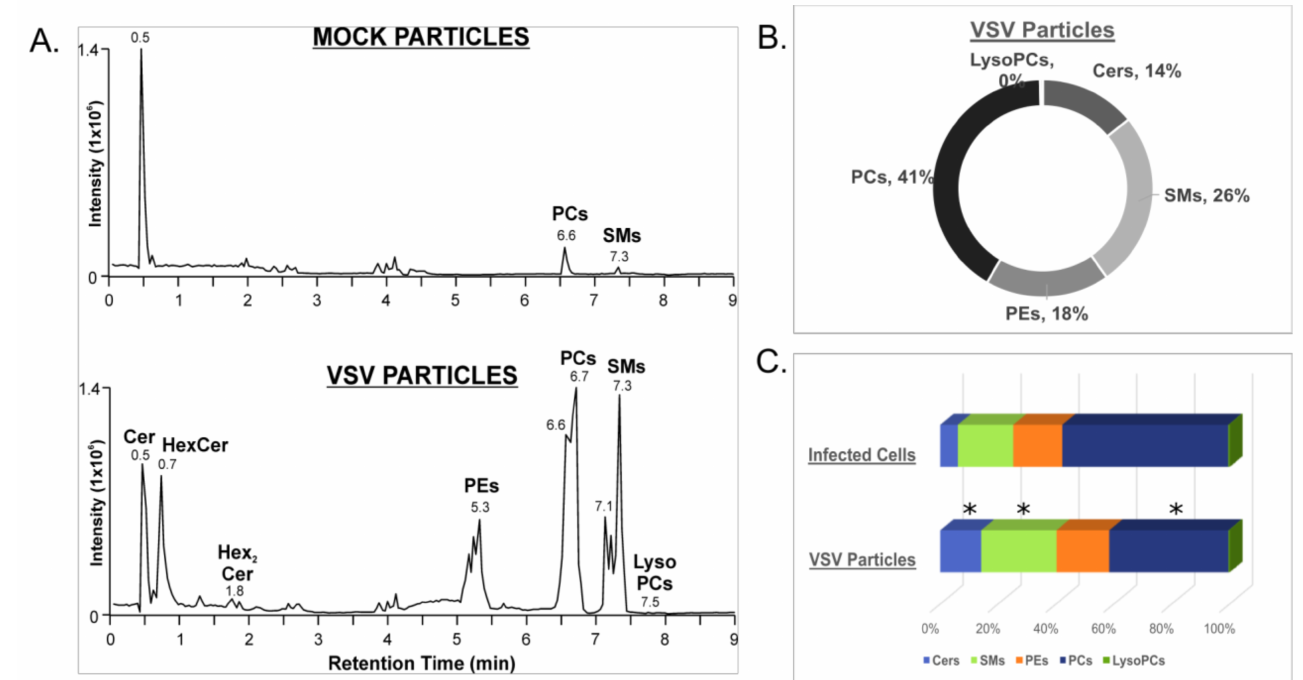
Figure 6. Lipid identification from the positive ionization mode data set for concentrated supernatants from mock- and VSV-infected cells. ( A ) Ion mobility extracted ion chromatograms of mock- and VSV-infected cell supernatants from positive ionization mode; ( B ) Proportions of major lipid classes identified in positive ionization mode from mock- and VSV-infected cell supernatants determined by integration of chromatographic peak areas; ( C ) Comparison of lipid compositions of infected cells and VSV particles derived from the infected cells’ supernatants. Statistically significant changes in lipid class composition are denoted with an asterisk, indicating p-values of less than 0.05 determined by Student’s t-test (two-tailed, unequal